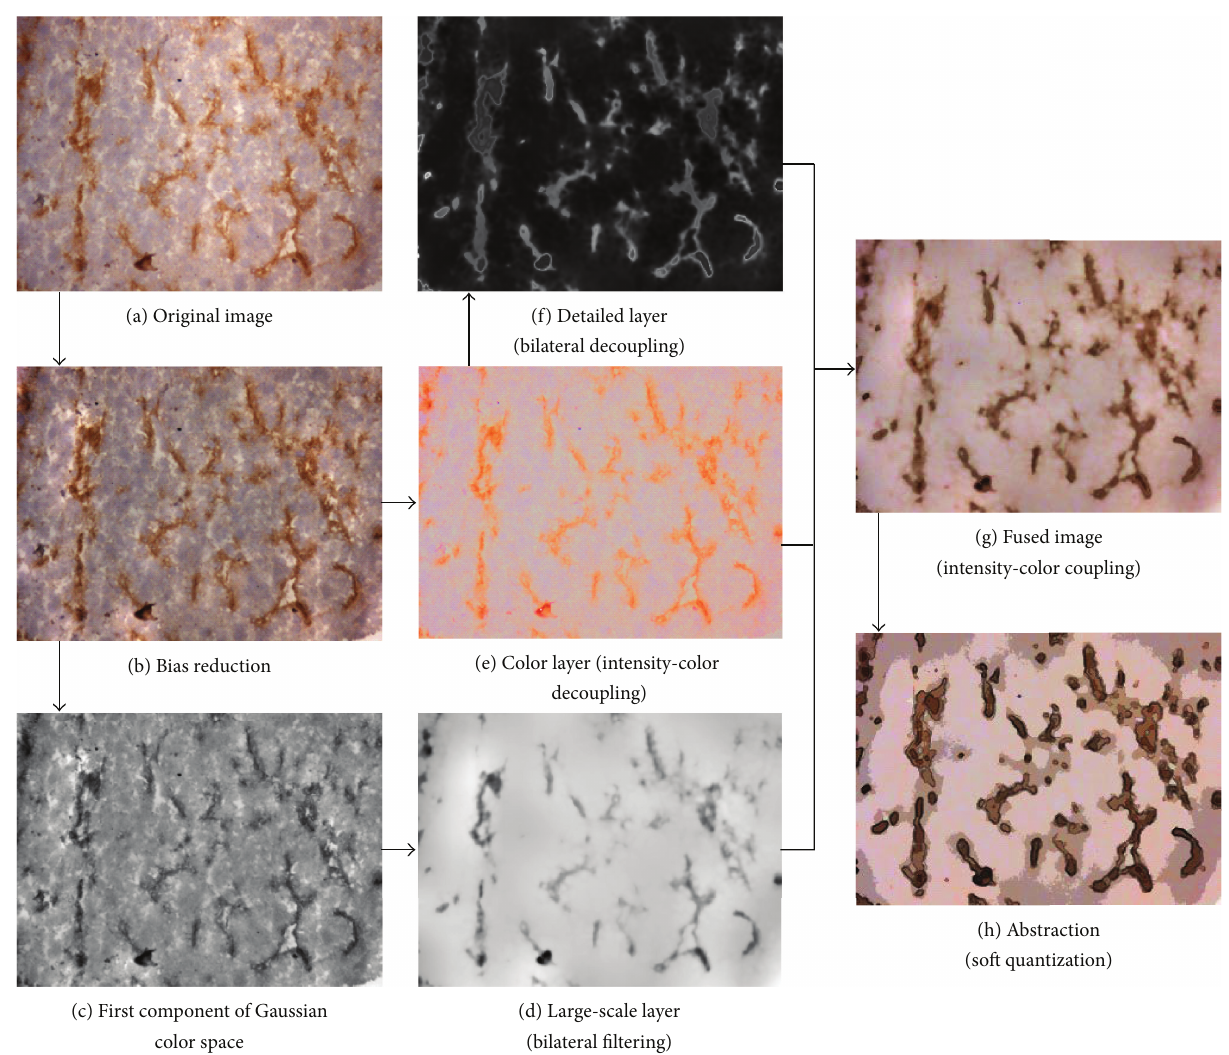
Figure 2: Flowchart of our proposed image filtering